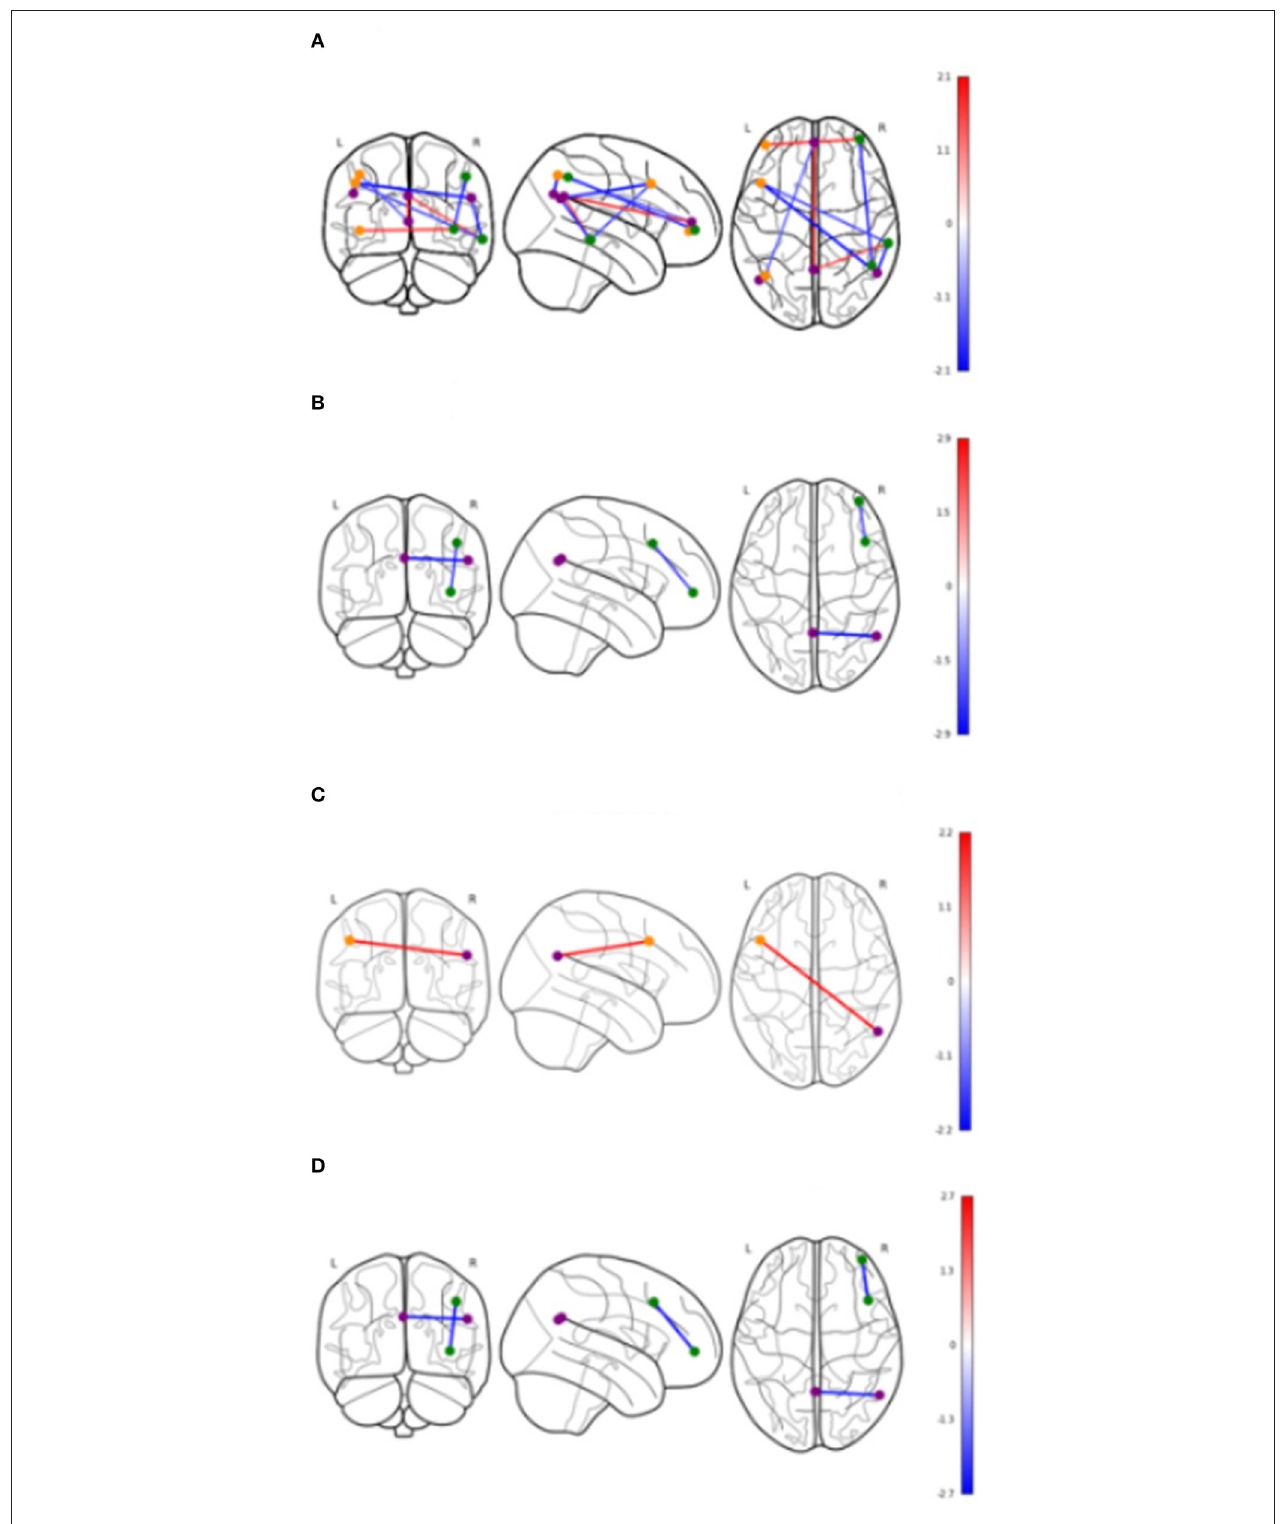
FIGURE 2 | Significant differences in functional connectivity between nodes by groups. Values shown in color bars are t -values. Line color represents t -values (warm = positive, cool = negative). Nodes are colored based on the network they belong to. Purple = DMN, Orange = Left FPN, Green = Right FPN. (A) Cerebrovascular event vs. Control (uncorrected). (B) Minor stroke vs. TIA (uncorrected). (C) Cerebrovascular event vs. Control (corrected). (D) Minor stroke vs. TIA (corrected).